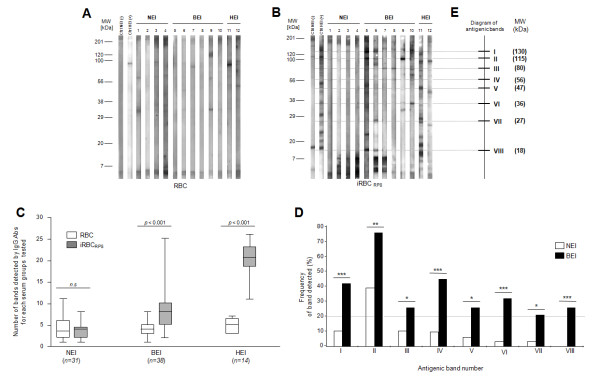
Analysis of immune response against iRBC membrane protein extracts using sera from non-exposed individuals (NEI), briefly exposed individuals (BEI) or highly exposed individuals (HEI) to malaria. IgG immune profiles from 4 NEI, 6 BEI and 2 HEI revealed by immunoblotting against erythrocyte membrane protein extracts from RBC (A), or iRBC (B) are presented. Two human sera, "Ctrl NEI (-)" and "Ctrl HEI (+)", loaded on each blot, were used as controls for antibody revelation and migration quality. MW: molecular weight, kDa: kiloDalton. (C) Comparative analysis of the antigenic bands number recognized by sera from NEI, BEI and HEI against RBC and iRBC membrane protein extracts. For this quantitative analysis, significant differences are indicated for each group tested between the two membrane protein extracts (p < 0.05, Mann-Whitney test). The line within the box represents the mean number of antigenic bands recognized by each sera group. The boundaries of the box indicate the 25th and 75th percentiles. Whiskers above and below the box indicate the maximum and minimum values. (D) Frequency of iRBC membrane antigenic protein bands detected by NEI and BEI. Analysis of IgG profiles using diversity database software (Biorad) allowed us to exhibit 8 antigenic bands from iRBC membrane protein extracts statistically significant (Fisher exact test, *p < 0.05; **p < 0.01, ***p < 0.001) between NEI and BEI groups. Only protein bands significantly different between NEI and BEI and detected by at least 20 percent of the individuals from a group were indicated. (E) These antigenic bands are indicated on a diagram using Roman numeral numbers, and their corresponding molecular weights are indicated in brackets.